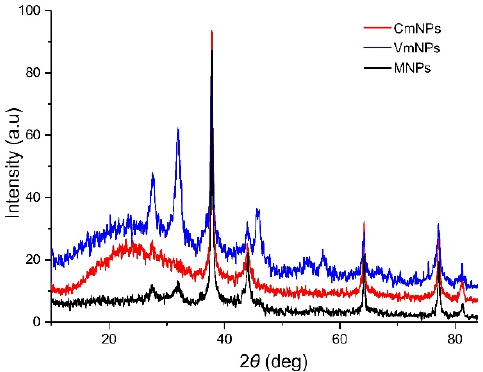
Figure 4. XRD pattern of resulted Ag-MnO 2 NPs.